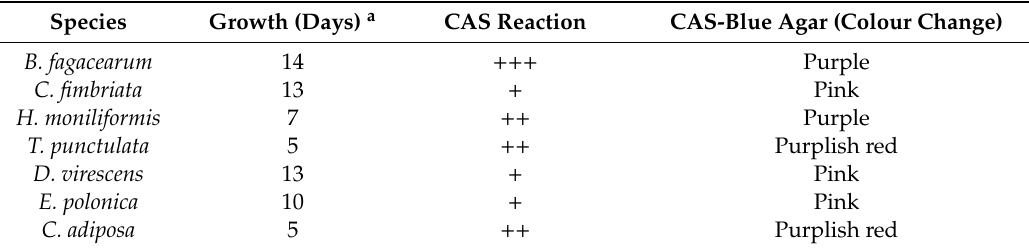
Table 2. Evaluation of siderophore production by di ff erent Ceratocystidaceae representatives included